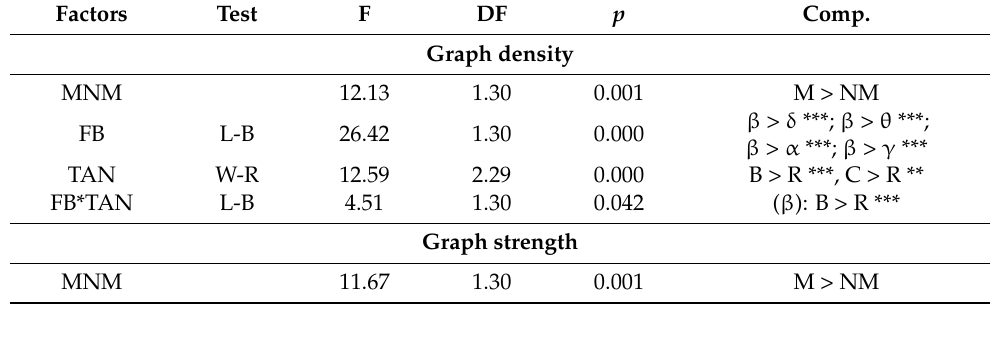
Figure 5. Mean values (±95% confidence interval) for the degree of EEG graph/network in the two groups of subjects (NM and M) in the 5 indicated EEG frequency bands and in the 3 auditions considered (T: tonal, A: atonal, and N: noise).